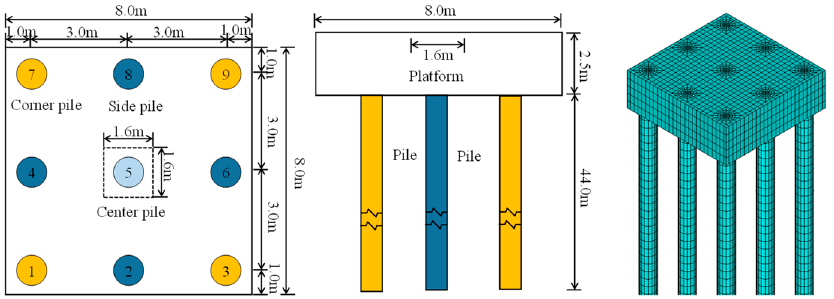
Figure 11. Dimensions and separations of pile groups and finite element mesh.